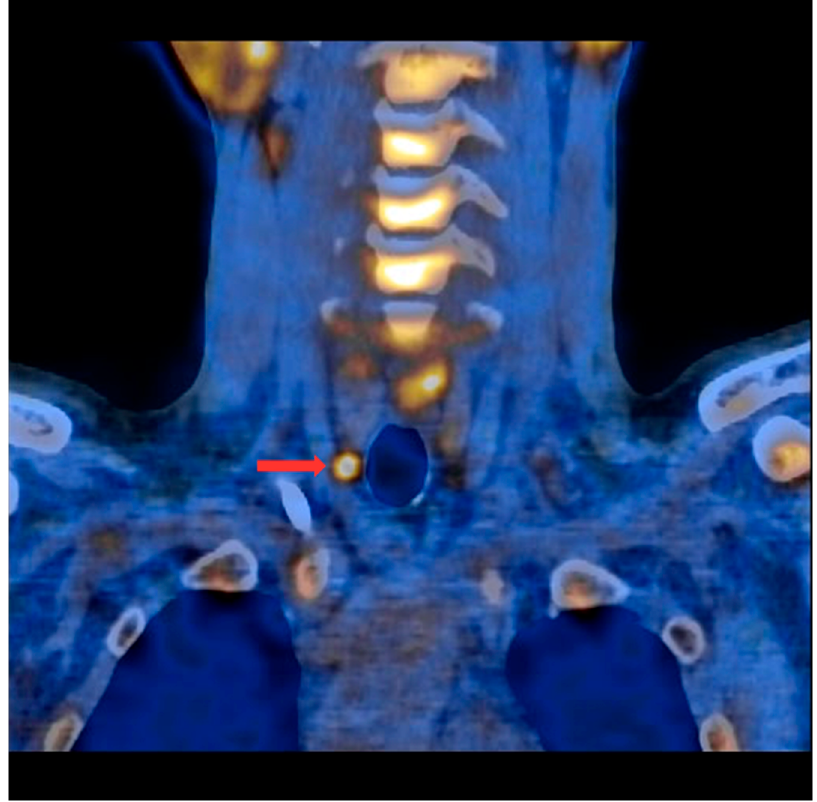
Figure 1. PET/CT with [ 11 C]MET—frontal projection. Visible focus of increased radiotracer accumu- lation (red arrow) corresponding to the parathyroid gland below the right thyroid